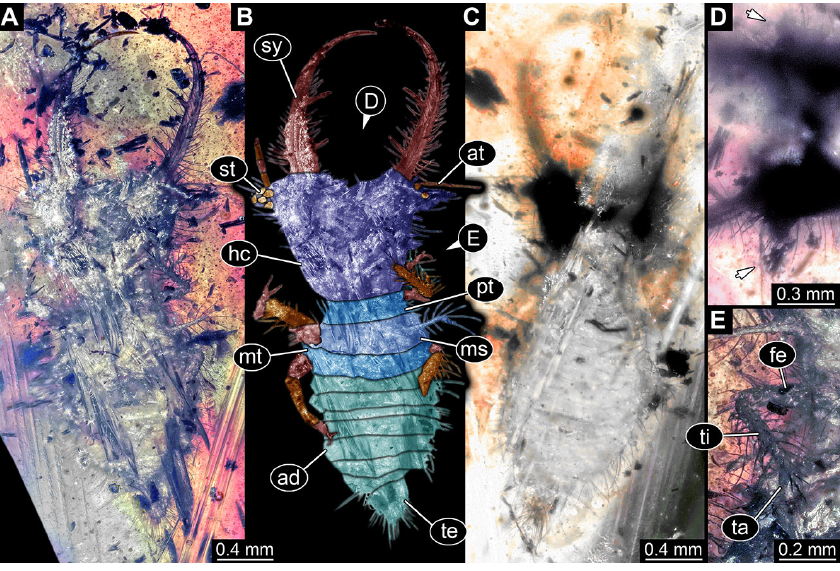
Figure 36. Fossil owllion larva, specimen 3249 (Weiterschan BuB 23), Cretaceous Kachin amber, Myanmar. ( A ) Overview, ventral. ( B ) Color-marked version of ( A ). ( C ) Overview, dorsal. ( D ) Close-up on head capsule with fields of stemmata (arrows). ( E ) Close-up on trunk with locomotory appendages. Abbreviations: ad = abdomen; at = antenna; fe = femur; hc = head capsule; ms = mesothorax; mt = metathorax; pt = prothorax; st = stemmata; sy = stylet; ta = tarsus; te = trunk end; ti = tibia.